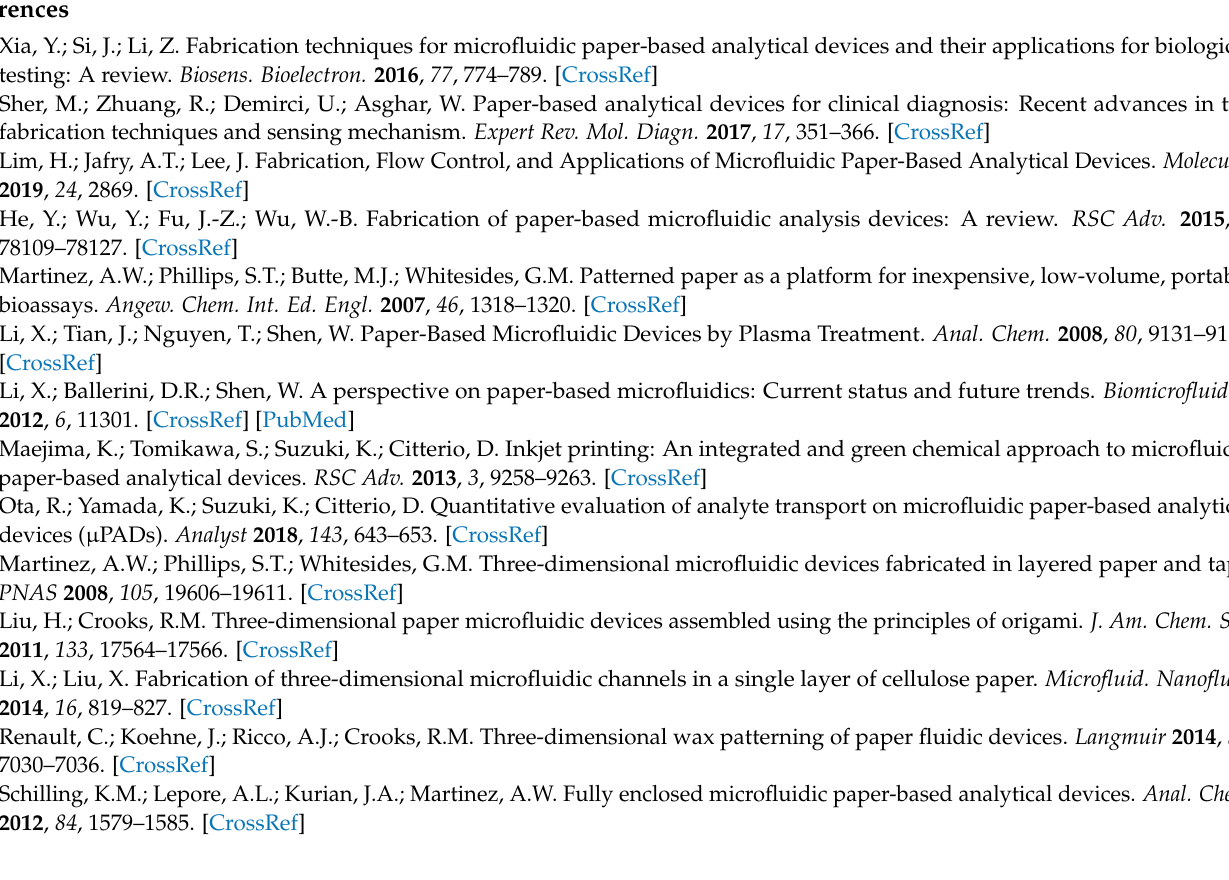
Figure S3: Measurement of gray intensity value of red dye according to channel location in hemi channel and enclosed channel. (a) Since evaporation occurred on all surfaces in the hemi channel, a large amount of red dye was placed in the channel, and the channel showed a high gray intensity value. (b) Since evaporation occurred only in the inlet and detection zone in the enclosed channel, a large amount of red dye was transported to the detection zone, which showed a high gray intensity value. Scale bar: 5 mm. Table S1: Channel formation height and wicking speed according to exposure time. To confirm the evaporation prevention effect of the enclosed channel, we flowed a small volume sample (10 µ L) through a 15 mm long channel to ensure that the sample reached to the detection zone. Video S1: A video was taken of the wicking of fluid flowing inside an enclosed channel with different heights. Video S2: Video recording of a small volume sample (10 µ L) flowing through the hemi channel and the enclosed channel of the same height (0.21 mm) to compare the evaporation of the sample. Video S3: a video was recorded of the color change of the detection area after the glucose sample was completely wetted with µ PAD. In the hemi channel, the color moved towards the channel and the intensity of the detection area decreased, whereas in the enclosed channel, the color moved to the detection area and became